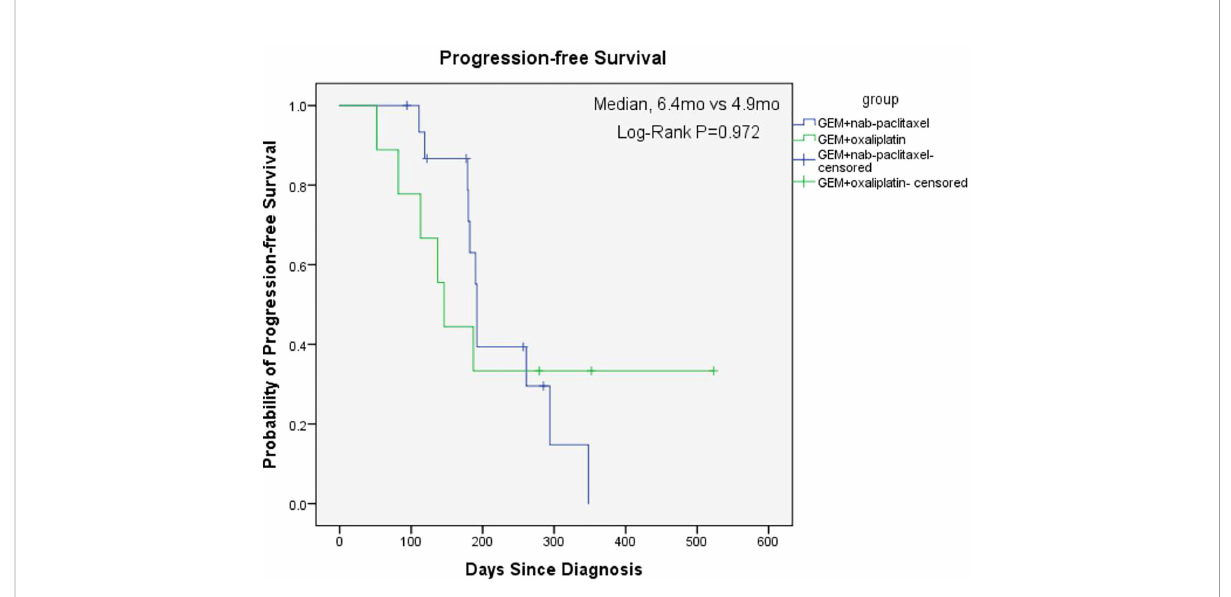
FIGURE 4 Kaplan-Meier Estimates of Progression-free Survival between two groups.